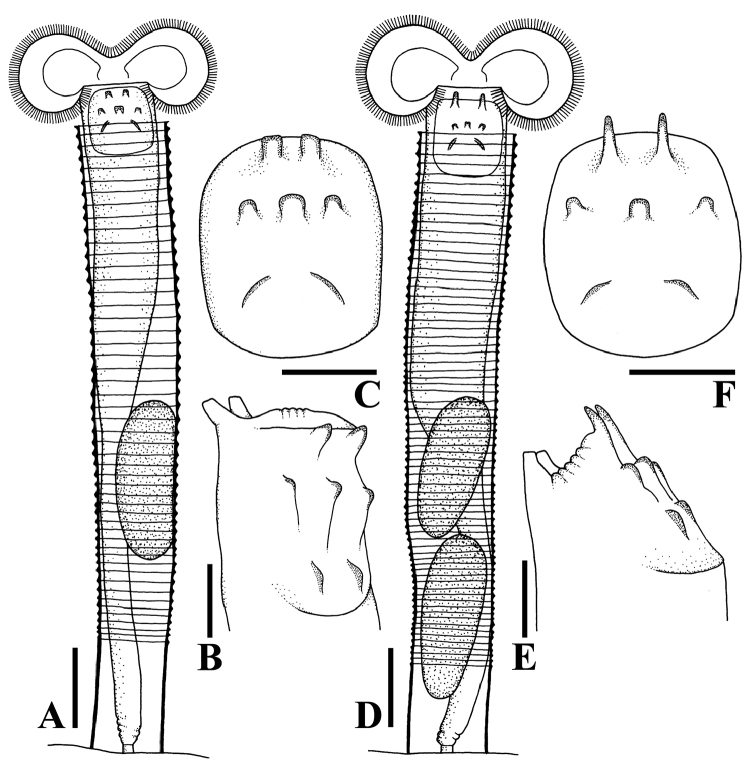
Line drawings of habitus and dorsal plate. A–CLimniasmelicerta SH D–FLimniasmelicerta LH. Scale bars: 50 µm (A, D); 25 µm (B, C, E, F).